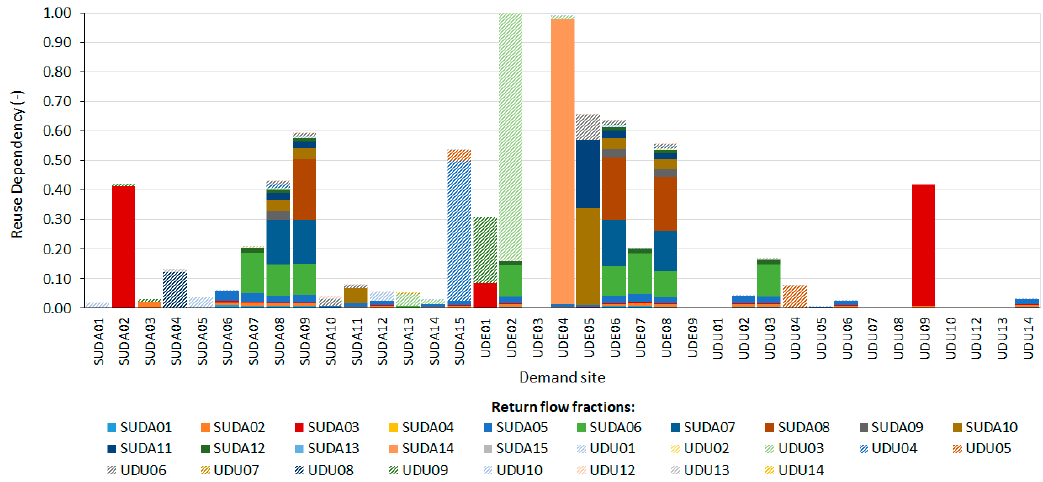
Figure 6. Reuse dependency of each water demand site disaggregated per upstream user contributing to the supply.